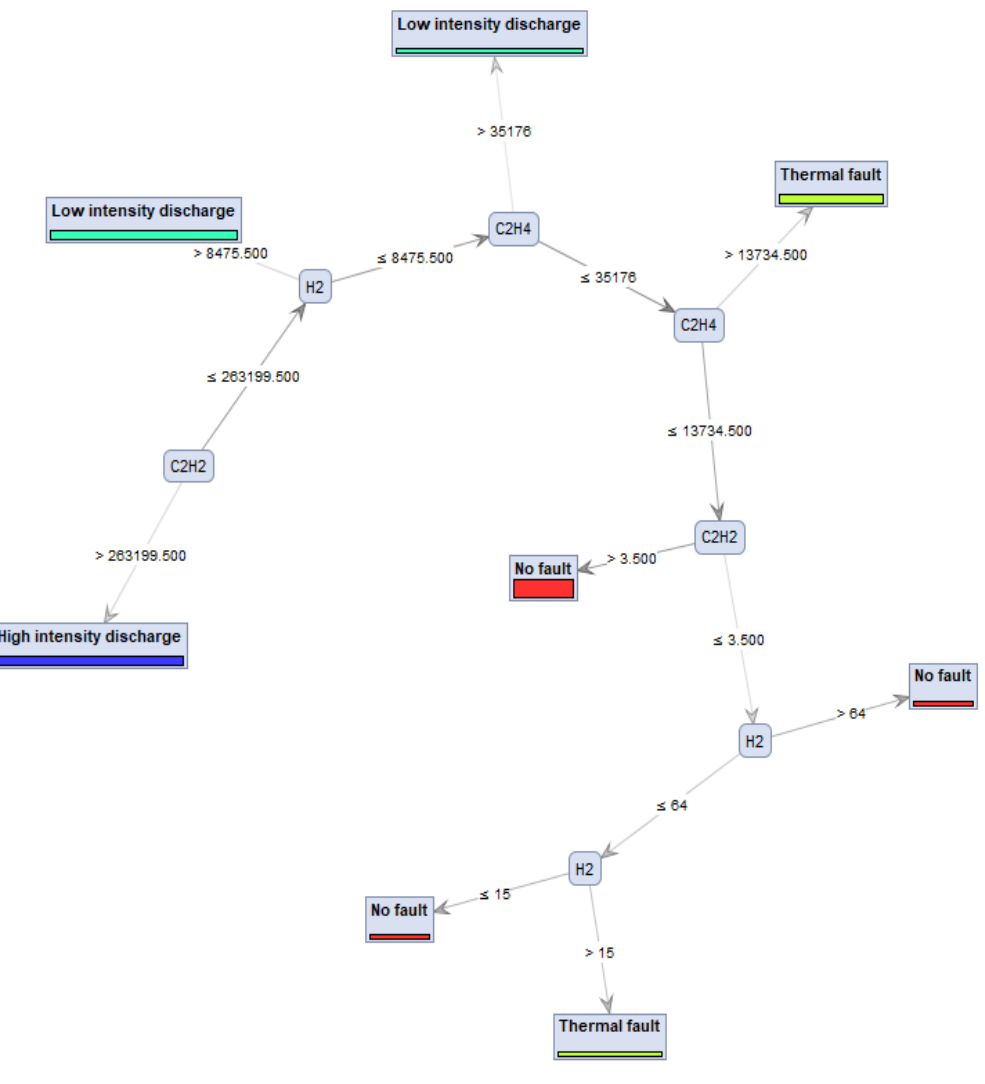
Figure 13. Random forest model graph.